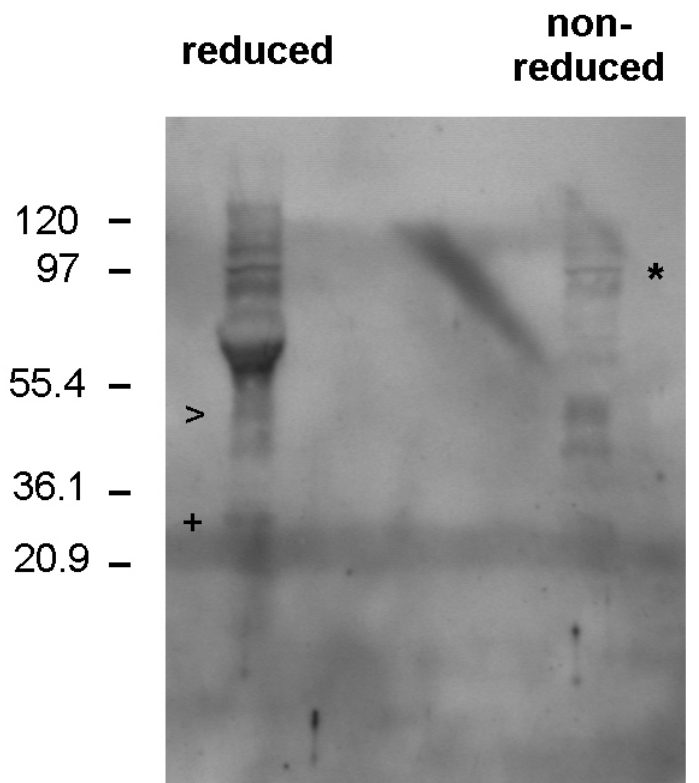
FIGURE 9. Western blot of btn-DCN-SASD cross-linked fibroblasts extracts probed for a 51-kDa decorin receptor. Human skin fibroblasts in monolayer culture were allowed to internalize btn-DCN-SASD for 10 min, followed by covalent cross-linking of biotinylated decorin to nearby bound proteins on photoactivation. Samples were processed as indicated in the legend of Fig. 8 and subjected to Western blotting and probing with a monospecific polyclonal antiserum directed against the p51 decorin receptor (1:1,000), followed by incubation with peroxidase-labeled goat-antirabbit IgG antibody and ECL detection[22].Under nonreducing conditions, a protein of a molecular mass of 97 kDa, but not of 165 kDa (cf. Fig. 8), is detected by the p51 antiserum (*). Under reducing conditions, bands of 97 and 60–70 kDa are detected in addition to the 51 kDa (>) and 26 kDa (+) receptor